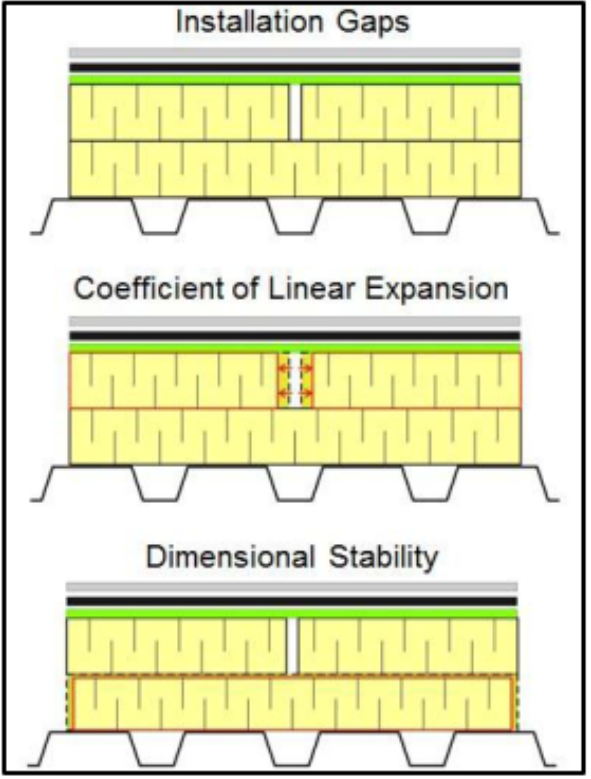
Figure 1. Causes of gap formation.